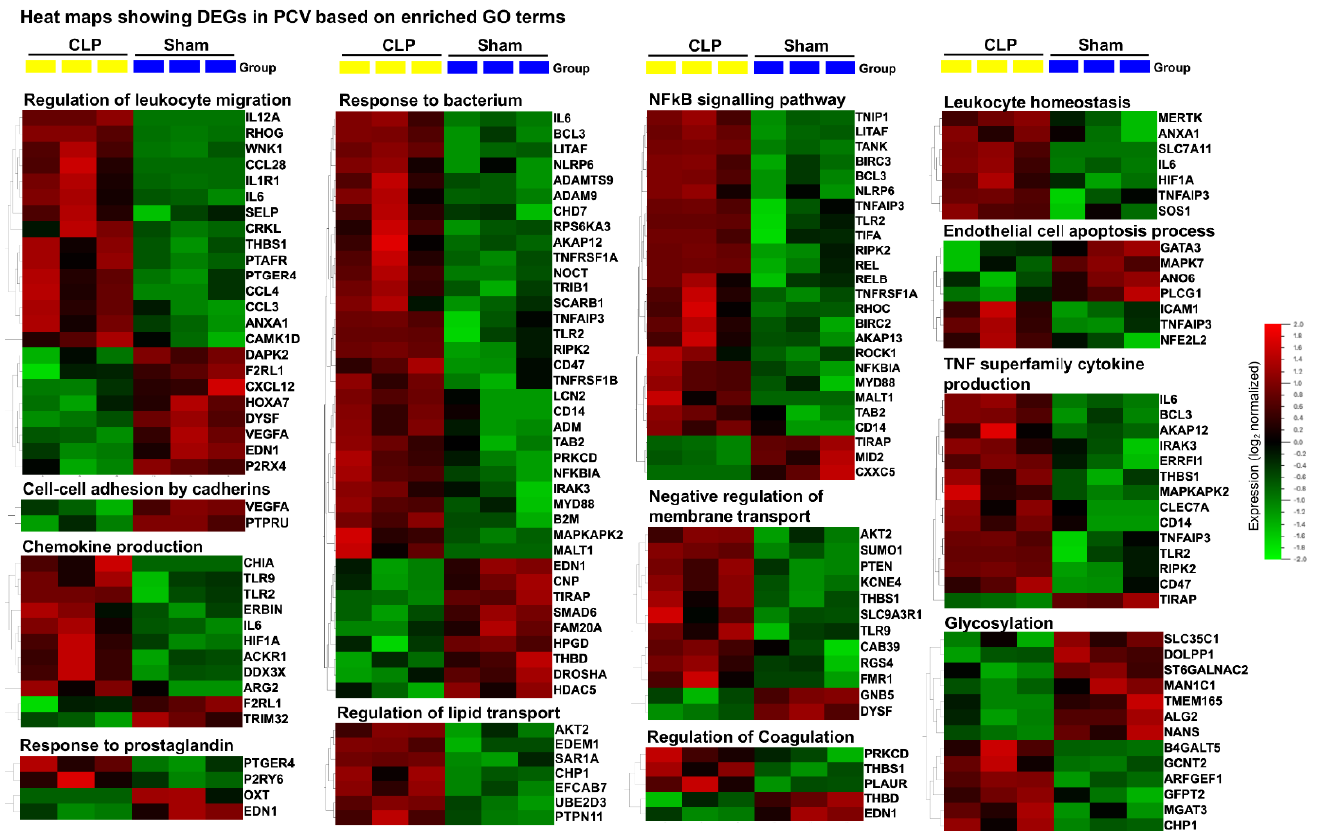
Figure 6. Heat maps showing DEGs ( p ≤ 0.05) with GO enriched term in PCV. Samples were collected 4 h after induction of abdominal sepsis. GO terms were based on biological process of Molecular Signatures Database (v7.2 MSigDB). For KEGG pathway analysis, mouse genes were converted to human orthologs as described in the materials and methods section. Hierarchical clustering of variables and box color of heat map was based on data normalization, mean = 0, variance = 1. Table 1. Top inflammation-related enriched KEGG pathways using top 500 DEGs from